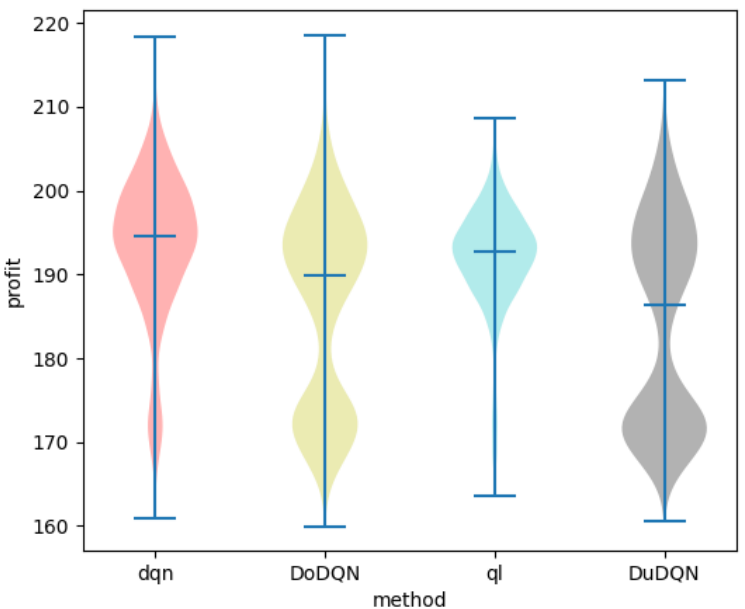
Figure 14. Comparison of profit using different methods.